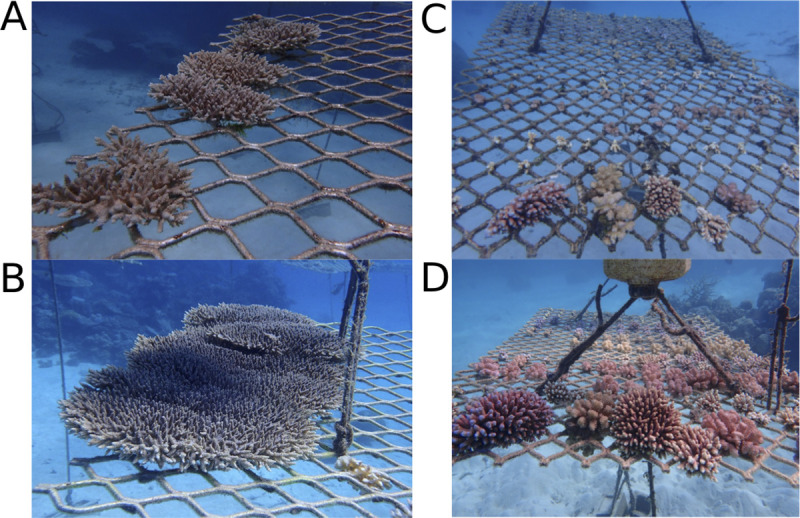
Visual examples of coral growth (Acropora hyacinthus) on the Blue Lagoon coral nursery from (A) 18th October 2018; and then (B) 26th August 2019. Examples of coral growth taken from RayBan nurseries from (C) 22nd October 2018; versus (D) 9th September 2019. Photographs taken by John Edmonsdon.